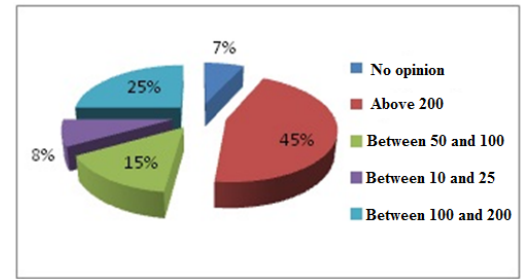
Figure. 4. Result of the question: do you click “like” on a post that you appreciate?